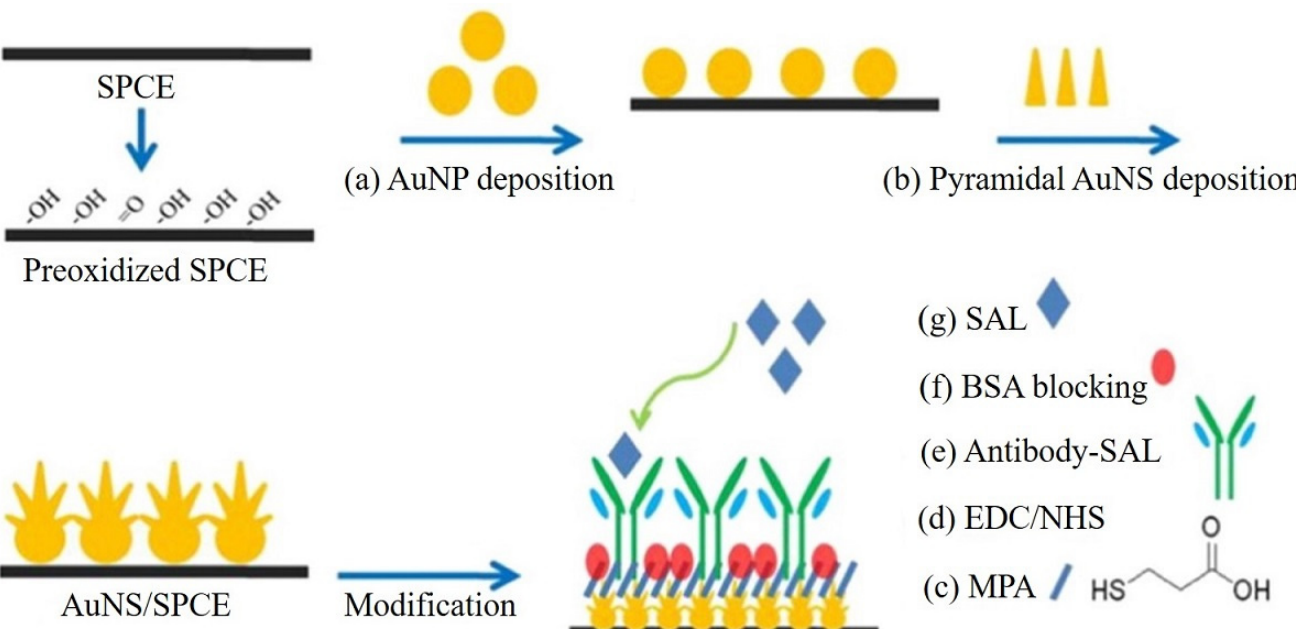
Figure 8. Schematic processes of the immunosensor construction (adapted and reprinted with permission from [127]).